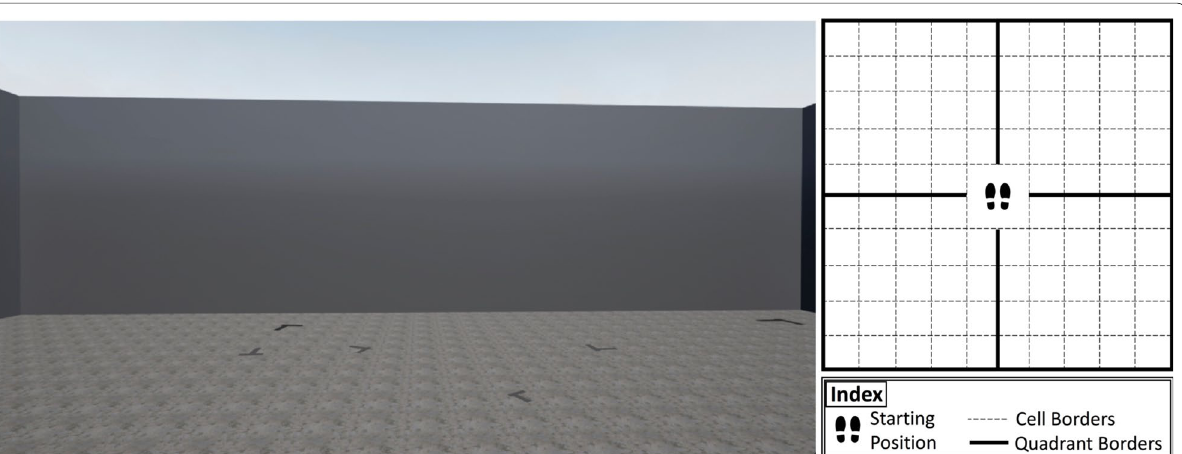
Fig. 1 Left) an image of an example search trial with the target T in the upper left quadrant in a light gray color and distractor Ls in the upper right and upper left quadrants, some appearing in light gray and some in dark gray. Right) a schematic of the search space, with 96 possible target locations, excluding a 2 2 cell space immediately surrounding the participant’s starting spot. The same number of search stimuli appeared in each × of the four quadrants outlined here (lines were not visible to